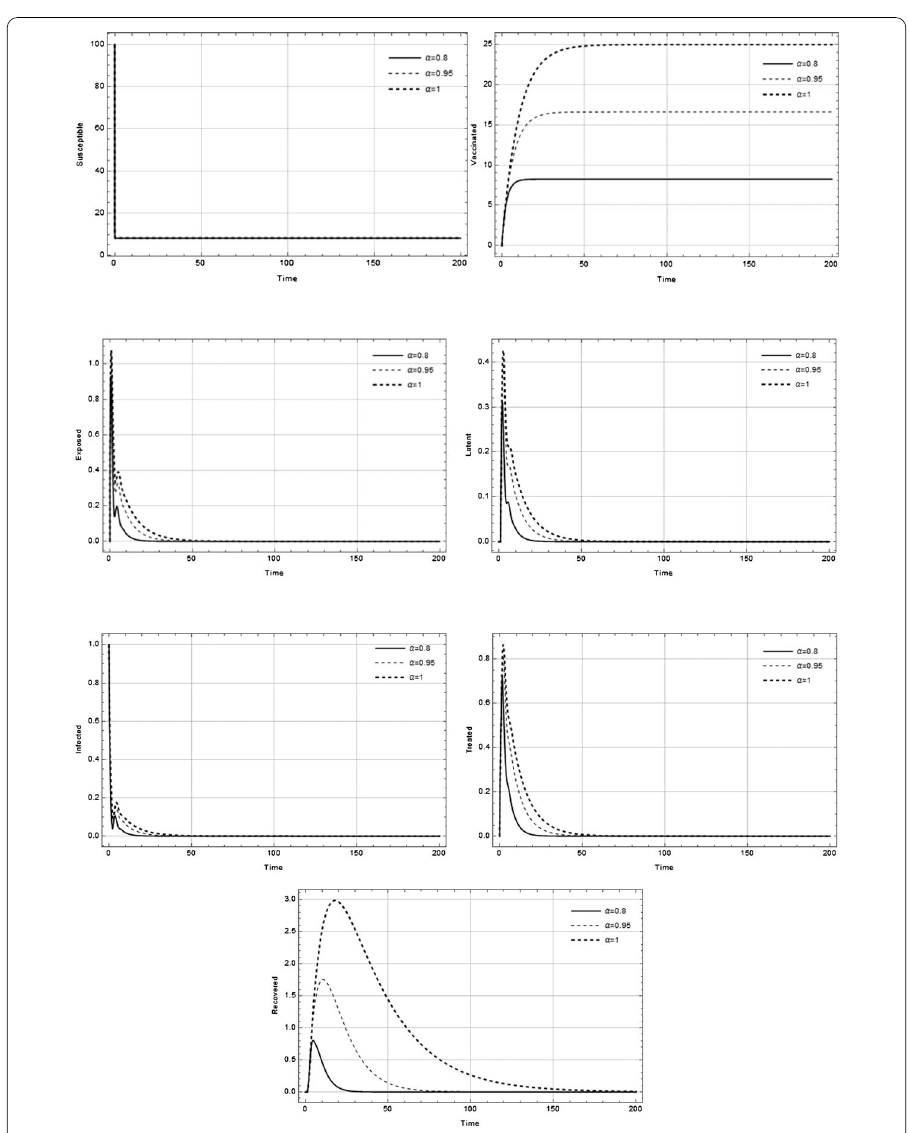
Figure 2 Disease-free equilibrium states of the SVELITR model at different values of α for R 0 < 1 and τ = 1